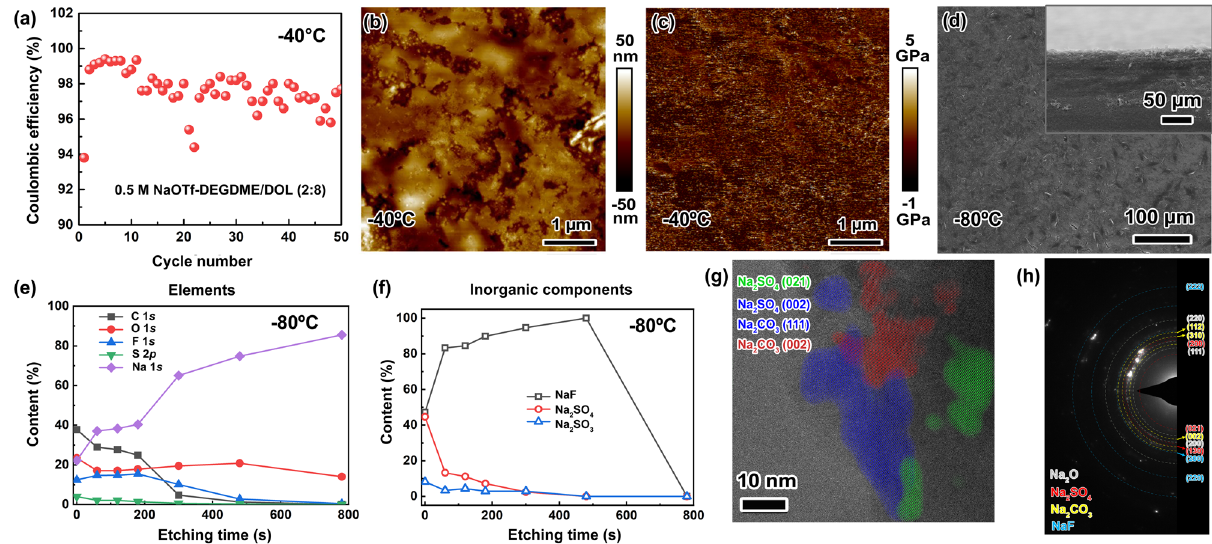
Fig. 5 | Electrochemical and physicochemical characterizations of Na metal electrodes cycled in 0.5M NaOTf-DEGDME/DOL (2:8) at low temperatures. a CEasafunctionofcyclenumberinNa||stainlesssteelcellsat − 40°Cat0.5mAcm − 2 and 0.5mAh cm − 2 . b AFM topography of the SEI formed on copper foil after Na plating/stripping at 0.5mAcm − 2 (0.5mAh cm − 2 ) with a cutoff voltage of 1.5V after the1stcycleat − 40°C(Cufoilisfullydesodiated). c Young ’ smodulus(determined byAFM)oftheSEIinFig.5b. d SEMoftheNametalelectrodesurfaceaftercyclingat − 80°C(Inset:correspondingcross-sectionalSEMimage). e ContentsofC1 s ,O1 s ,F 1 s ,S2 p andNa1 s elementsintheSEIat − 80°C. f ContentsofthemainSEIinorganic components, including NaF, Na 2 SO 4 and Na 2 SO 3 , at − 80°C. g Cryo-TEM image of